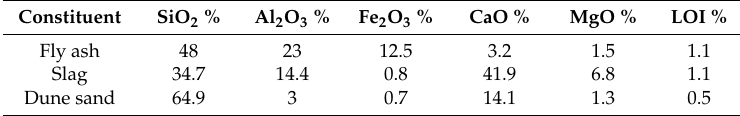
Table 3. X-ray fluorescence (XRF) test results.